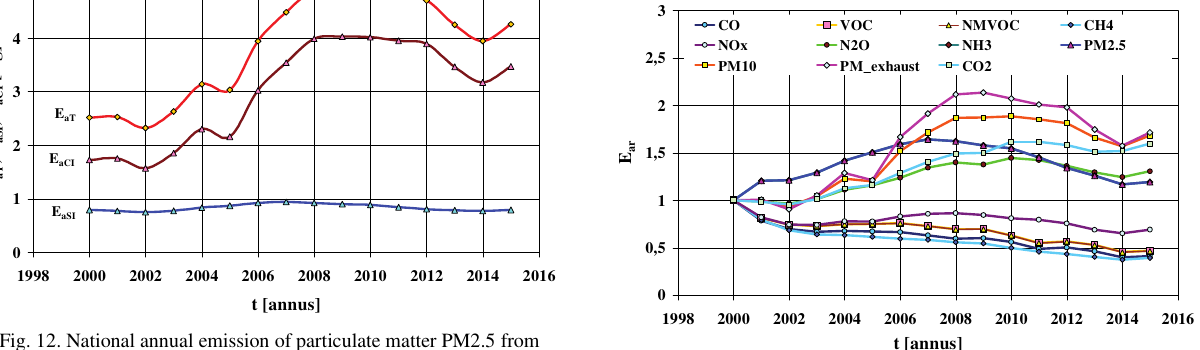
Fig. 16. Relative national annual emission of individual pollutants